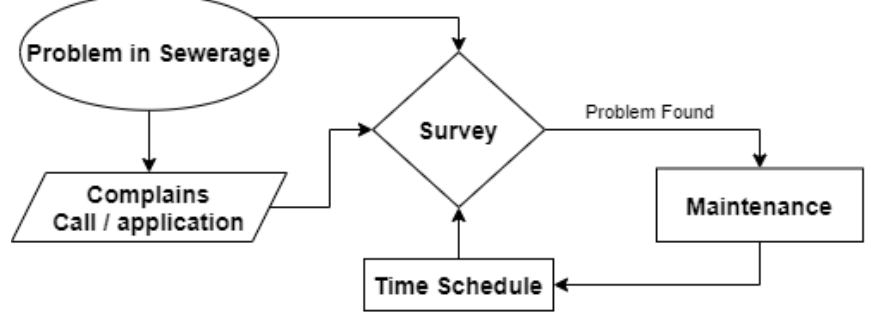
Figure 1. Flow chart of a man-powered sewerage maintenance system.